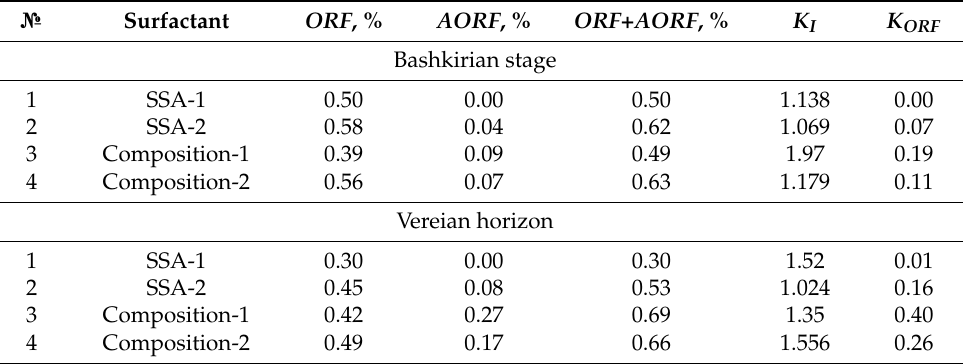
Figure 8. Displacement rate and oil displacement coefficient during spontaneous imbibition for Vereian horizon cores of: ( a ) oil; ( b ) microemulsion; ( c ) dynamic of oil displacement coefficient during Amott cell experiment, K IORF unit fraction. Table 9. Experimental data on filtration experiments’ surfactant concentration 0.3%